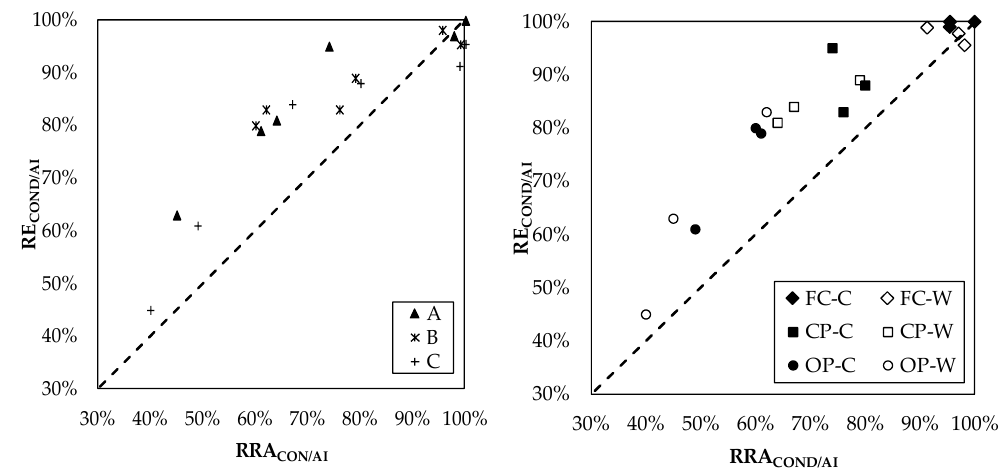
Figure 4. HE ratios for all the underwater testing conditions, with AI as control condition. Left to right: Points labelled by different material and by different SSRT conditions.